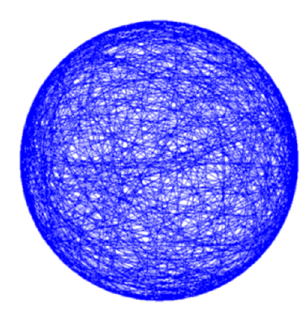
Figure 8. Optimized control scheme leads to homogeneous and controlled path distribution (with excellent uniformity F* = 3.6) for zero or partial gravity applications.